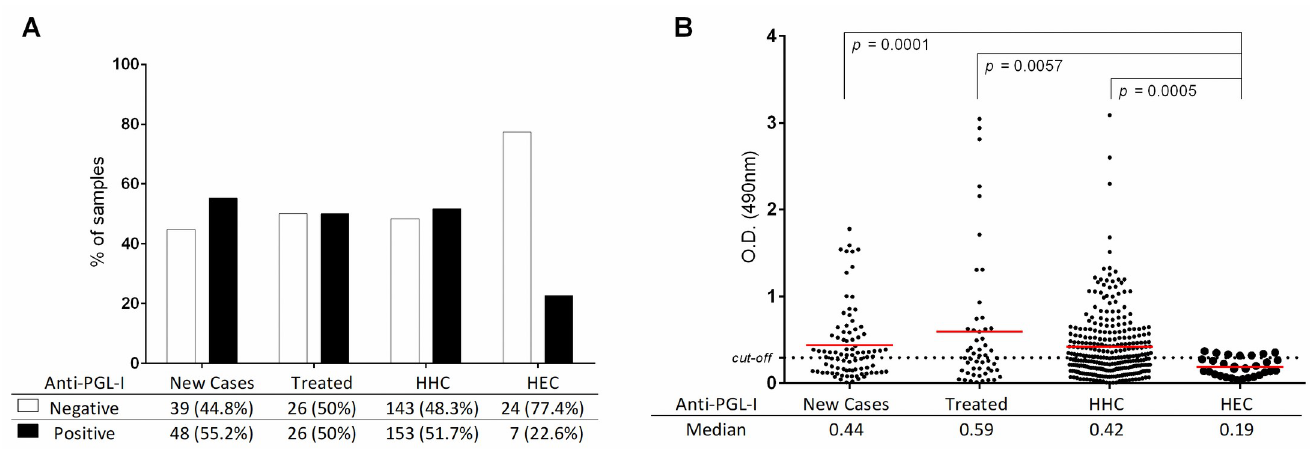
Fig 1. Frequency of anti-PGL-I positivity in new cases, treated cases, HHC and HEC. A) Positivity versus negativity in anti-PGL-I titers with a similar percentage of positives observed in newly diagnosed cases, treated cases, and household contacts, while those in the HEC group were negative or weakly above the cut-off. B) Anti- PGL-I optical density (O.D.) for all individuals was plotted for each group with the median O.D. indicated by the solid horizontal line. The significant p value differences between groups are shown.